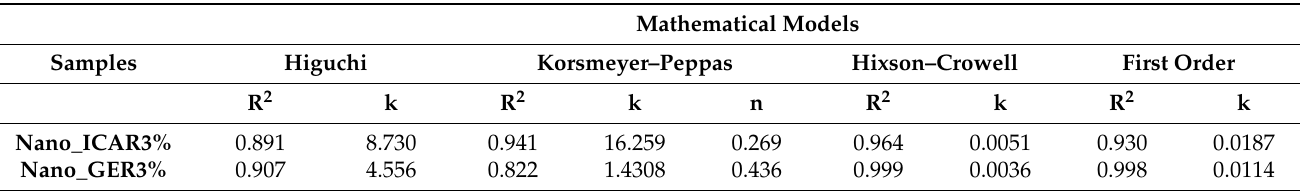
Table 1. Correlation coefficient (R 2 ) for the different mathematical models used for the release kinetics of nanocapsules containing the active substances geraniol and